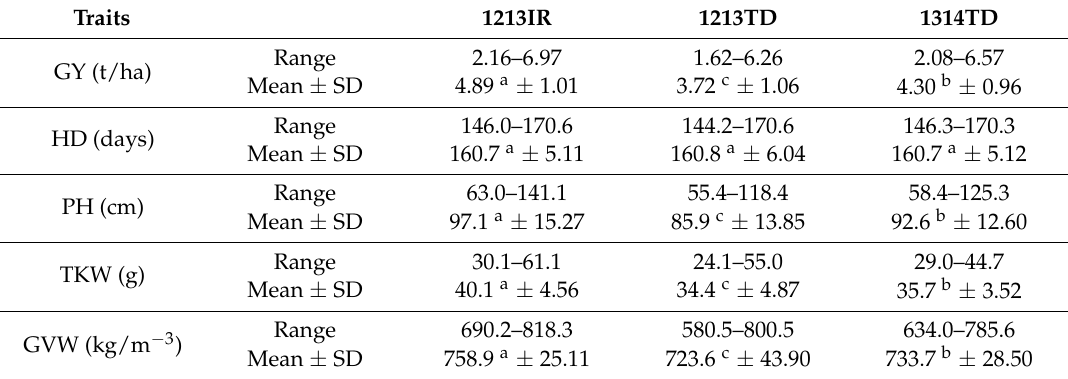
Table 5. Mean value and standard deviation (SD) of traits measured in three